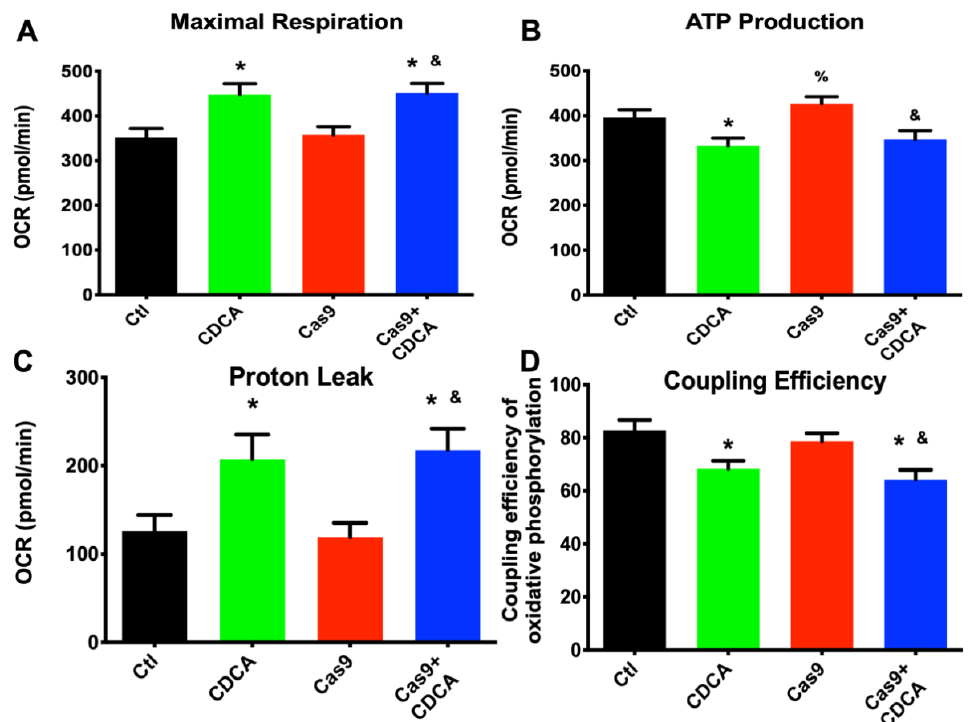
Figure 2. Seahorse respiration data obtained from 3T3-L1 adipocytes exposed to CDCA in the absence or presence of TGR5. ( A ) Maximal respiration; ( B ) ATP production; ( C ) Proton leak; ( D ) Oxidative phosphorylation coupling efficiency. Data are derived from 12 independent experiments, and bars represent means ± SEM. * indicates a statistically significant difference vs. Control ( p < 0.05); % indicates a statistically significant difference vs. CDCA ( p < 0.05); & indicates a statistically significant difference vs. Cas9 ( p < 0.05).